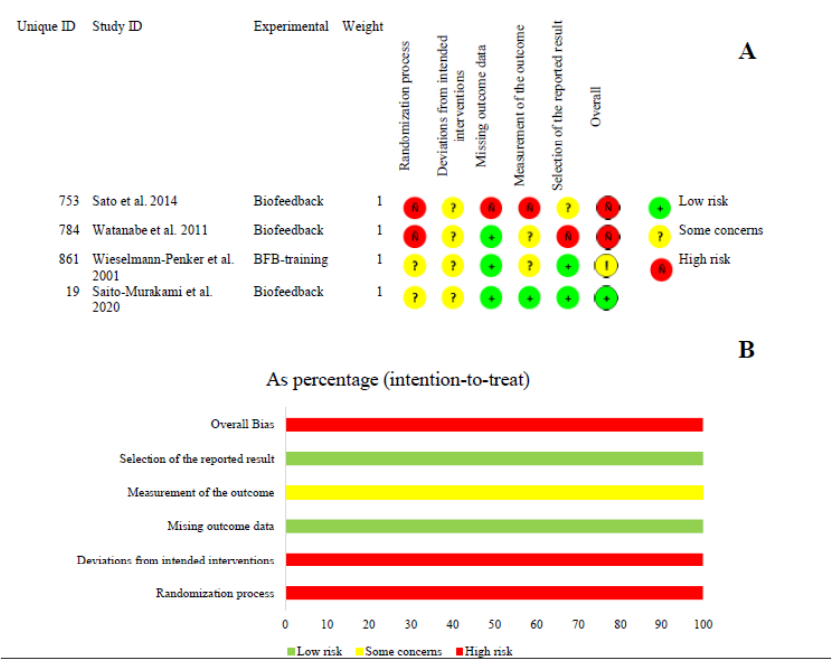
Figure 2. Risk of bias – Rob2. ( A ) The risk of bias by domain is presented in five domains (columns) and specified by studies (lines). ( B ) Risk of bias is presented for all studies combined as percentage based on the frequency of low, unclear, and high risk of bias. (The intention-to-treat approach was used as the basis for this analysis) [24,32 –